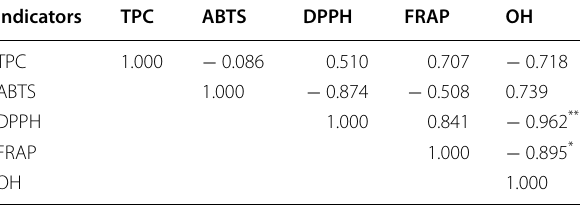
* indicates significant, p < 0.05; ** indicates highly significant, p <